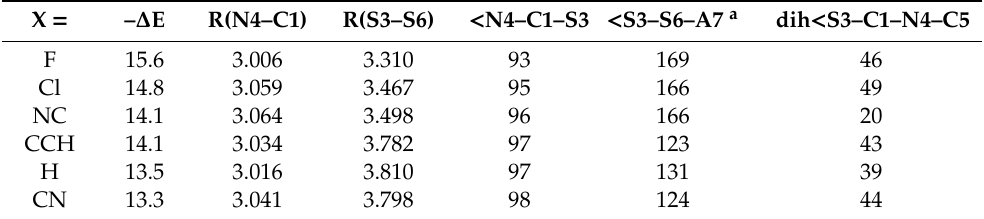
1 ; ( b ) H, C 1 ; ( c ) NC, C 1 ; and ( d ) H, C s